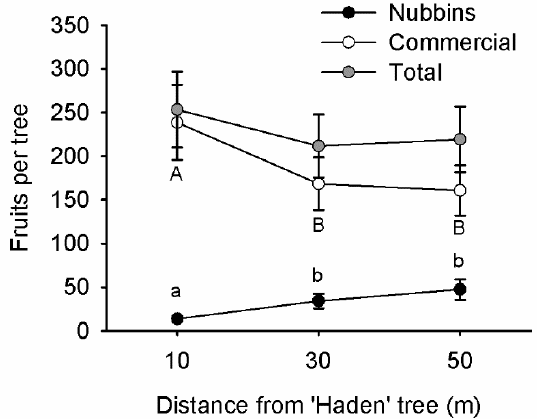
Figure 3. Mango production per tree (mean ± SE; n = 24 trees per distance) of ‘Ataulfo’ trees lo- cated at different distances from ‘Haden’ trees in 12 orchards of the Costa Grande, Guerrero, Mex- ico in 2020. Different letters indicate statistical differences among distances according to GLMM and Tukey test ( p <